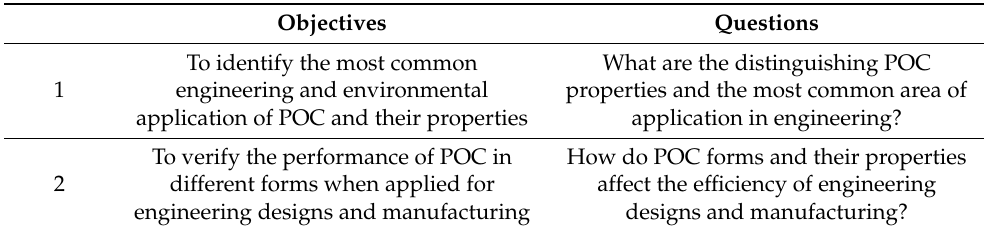
Table 3. SLR objectives and